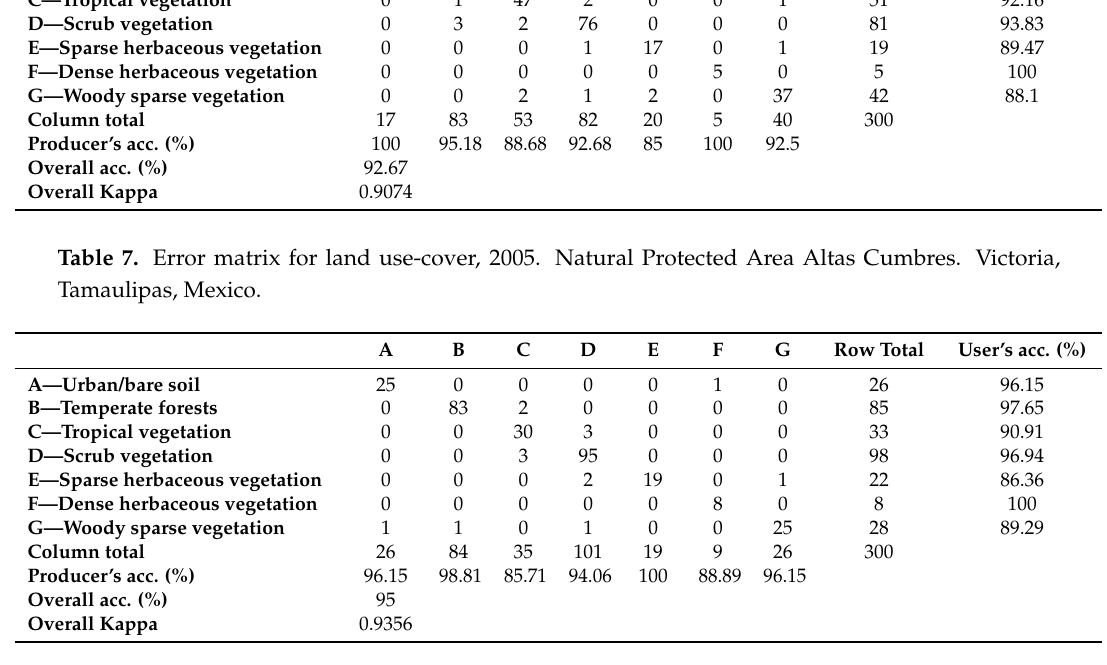
Table 8. Error matrix for land use-cover, 2015. Natural Protected Area Altas Cumbres. Victoria, Tamaulipas,